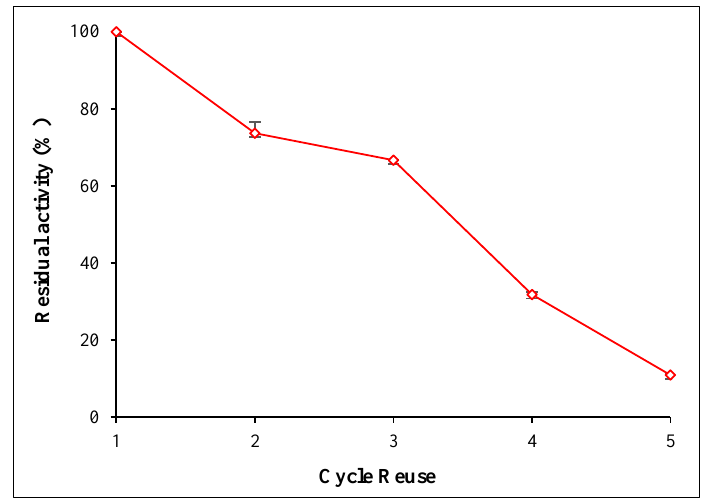
Figure 8. Reusability assay of the immobilized enzyme (mean ± SD; n = 2; p < 0.05)